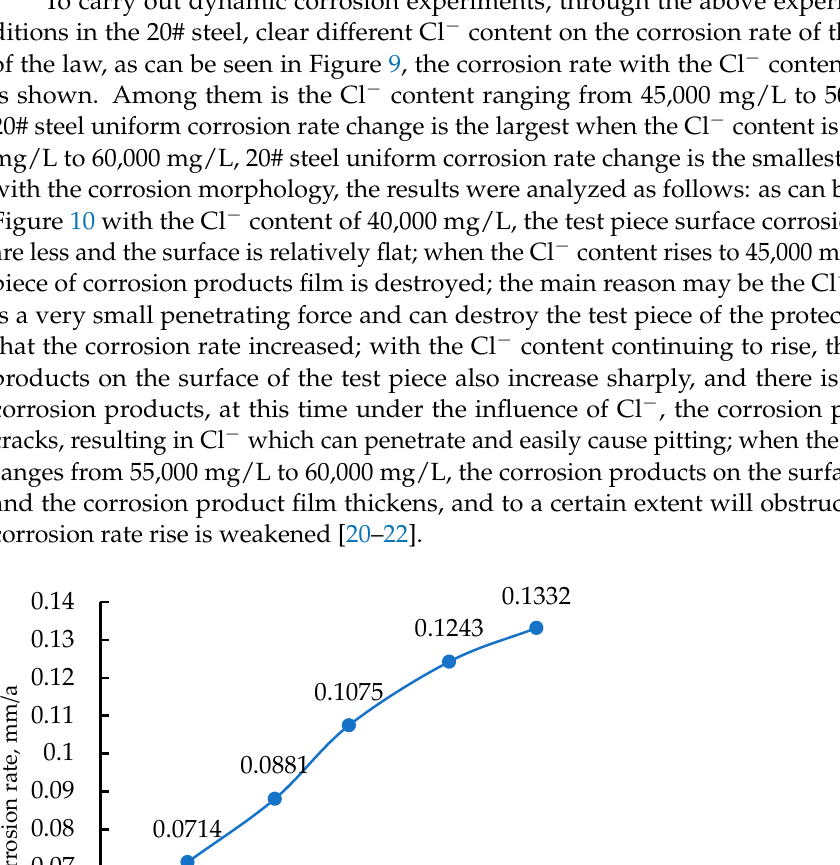
( e ) Figure 10. Microscopic corrosion morphology of hanging piece under different Cl − content. ( a ) Cl − content 40,000 mg/L; ( b ) Cl − content 45,000 mg/L; ( c ) Cl − content 49,250 mg/L; ( d ) Cl − content 55,000 mg/L; ( e ) Cl − content 60,000 mg/L. 3.6. Analysis of Main Control Factors To establish the main control factors influencing the corrosion of the oil–water mixed transmission system in the high water content period of the HH oil field, five influencing factors: temperature pressure, Ca 2+ + Mg 2+ content, CO 2 partial pressure, Cl − content, and SRB content were set as independent variables, and the corrosion rate of the test piece was set as the dependent variable, and Eta correlation analysis was performed using the mean comparison of SPSS; the operation results are shown in Figure 11. Eta squared represents “the proportion of the variance of the dependent variable explained by the difference be- tween groups”. Eta squared is less than 0.06, indicating that the correlation between the variables is weak; this degree does not reach statistical significance, that is, the results are not statistically significant, cannot determine whether the difference in the mean value is